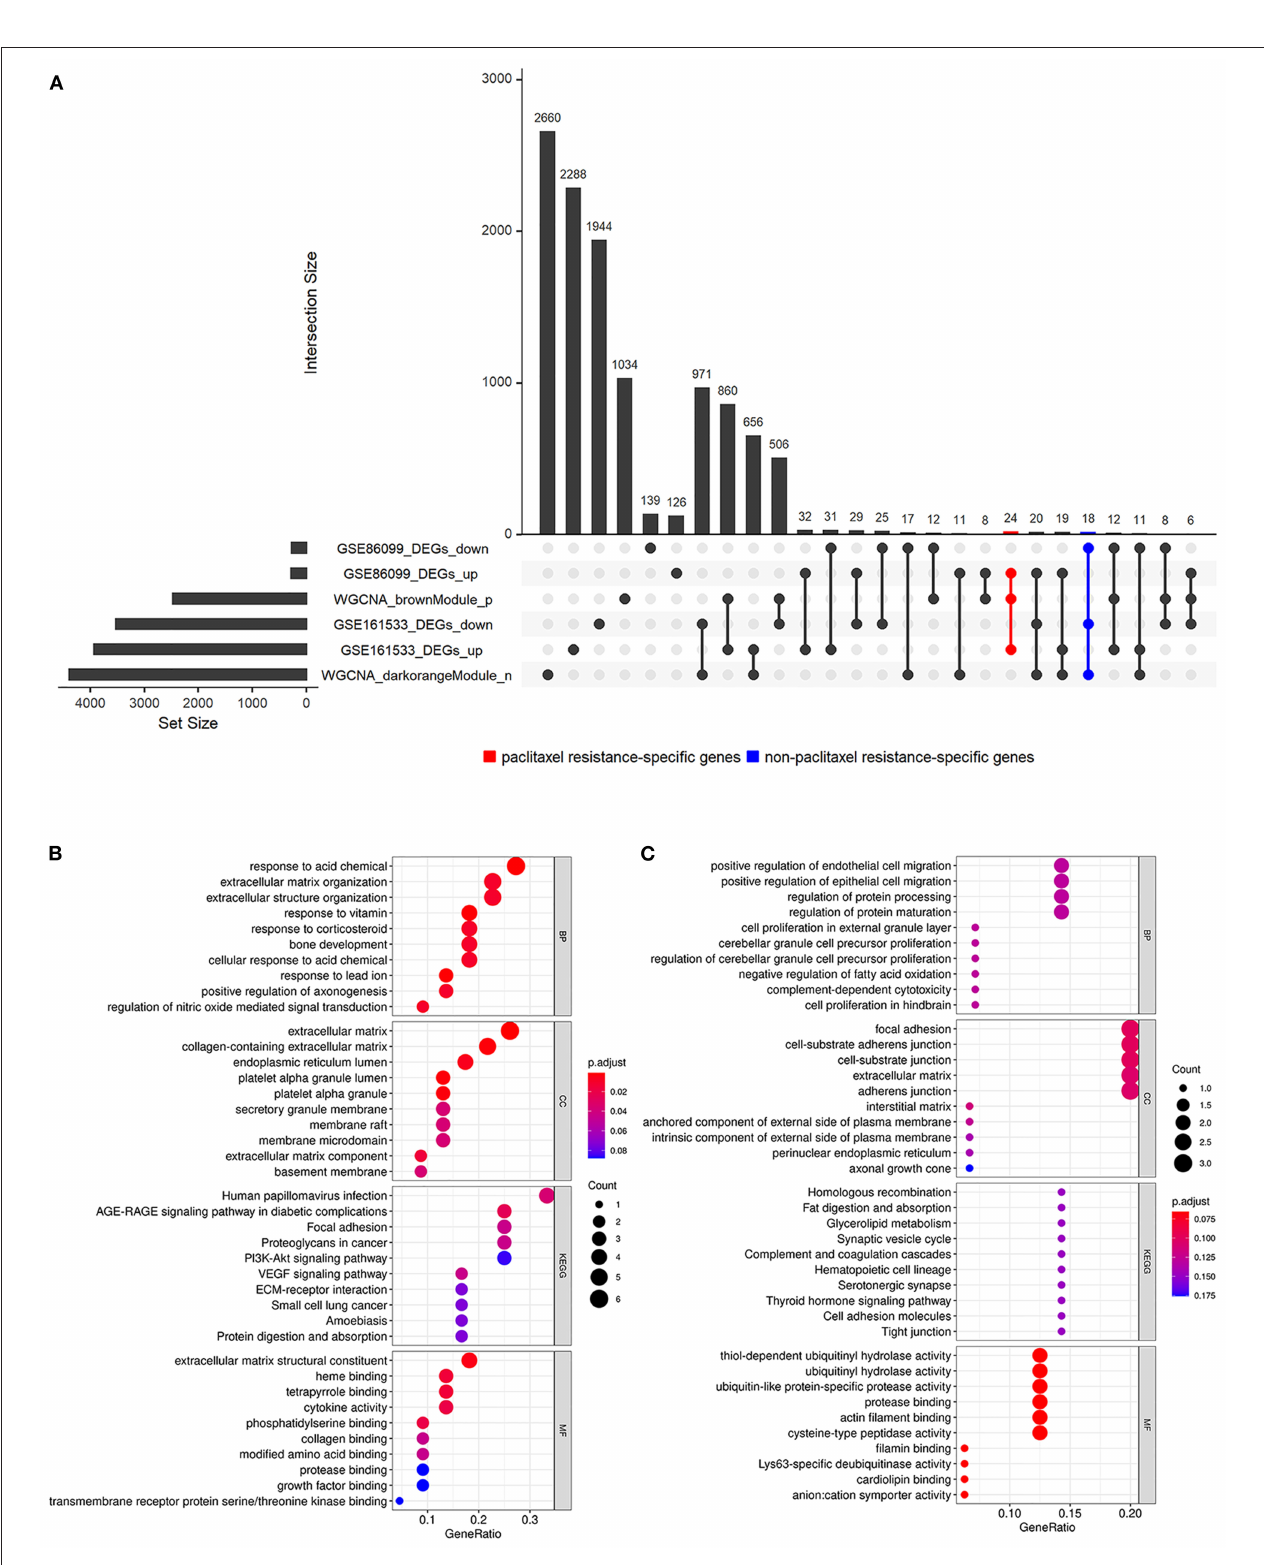
FIGURE 4 | Intersection and functional enrichment analysis of the differentially expressed genes (DEGs) of two Gene Expression Omnibus (GEO) datasets and the genes in esophageal squamous cell carcinoma (ESCC)-specific modules. (A) Upset plot of the DEGs identified in GSE86099 and GSE161533 and the genes in the ESCC-specific modules selected by weighted gene co-expression network analysis (WGCNA). (B,C) Function enrichment analyses of the paclitaxel resistance-specific (B) and non-paclitaxel resistance-specific (C) genes.